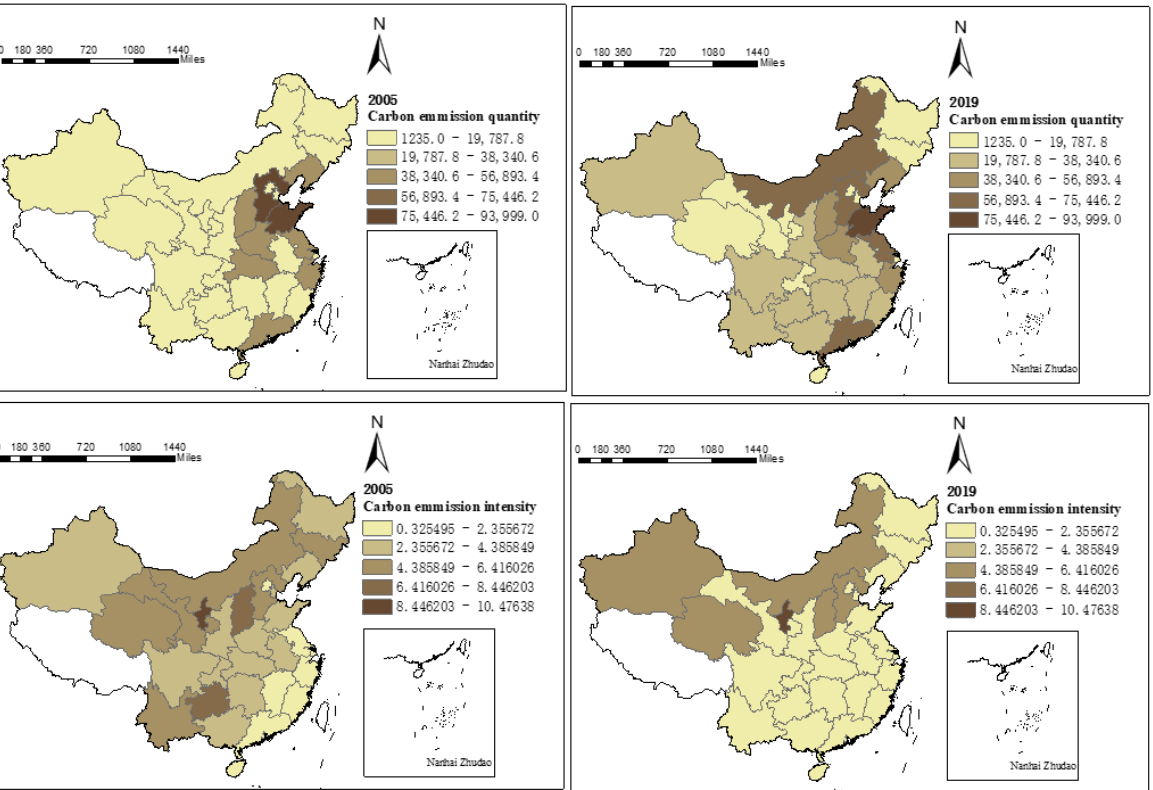
Figure 2. Spatial distribution of carbon emissions from production energy consumption in 30 provinces of China.